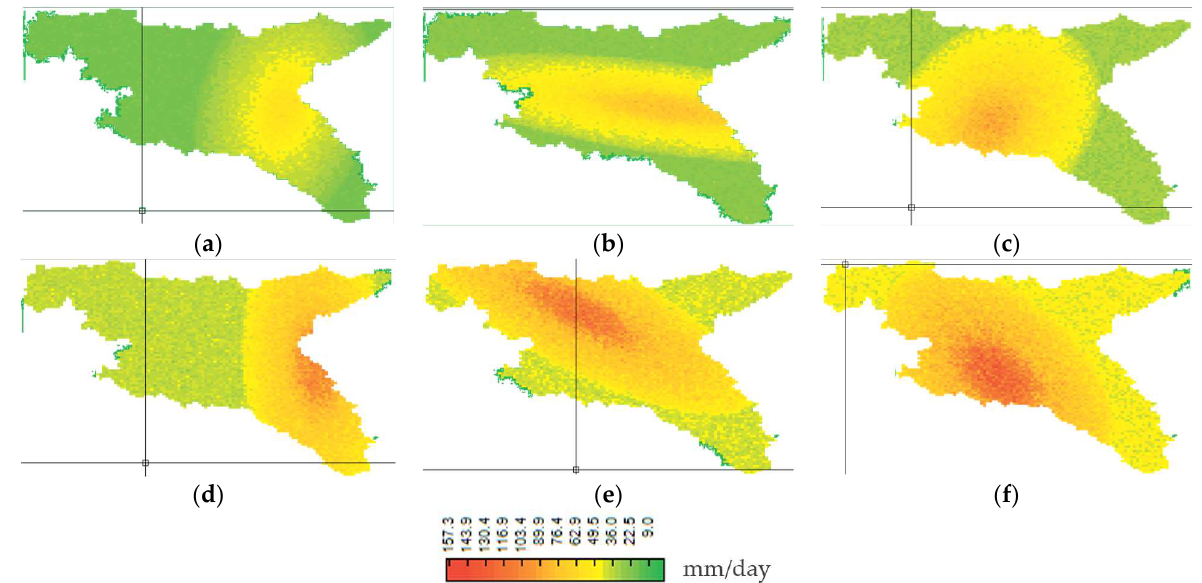
Figure 10. Illustrative examples of stochastic rainfall scenarios for the climatic scenario RCP 2.6 and the short-term period for the return periods of ( a ) 2 years; ( b ) 5 years; ( c ) 10 years; ( d ) 25 years; ( e ) 50 years; ( f ) 100 years (mm).